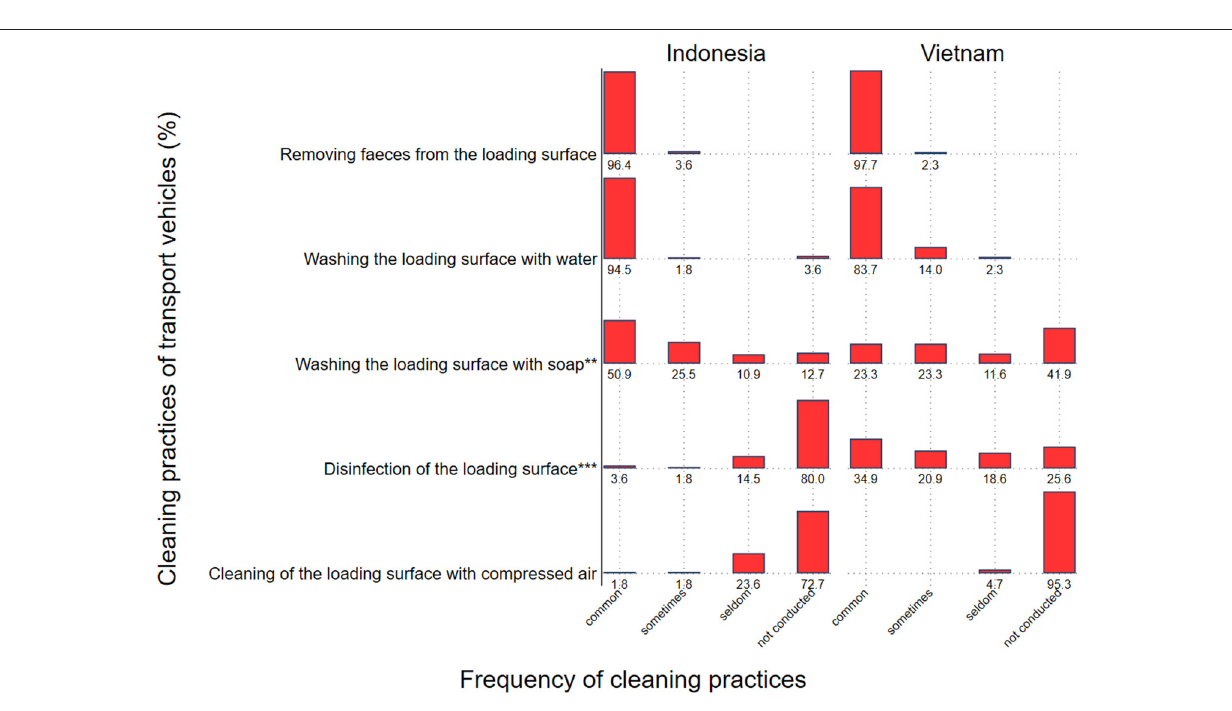
were similar for both countries ( p = 1; and p = 0.10,